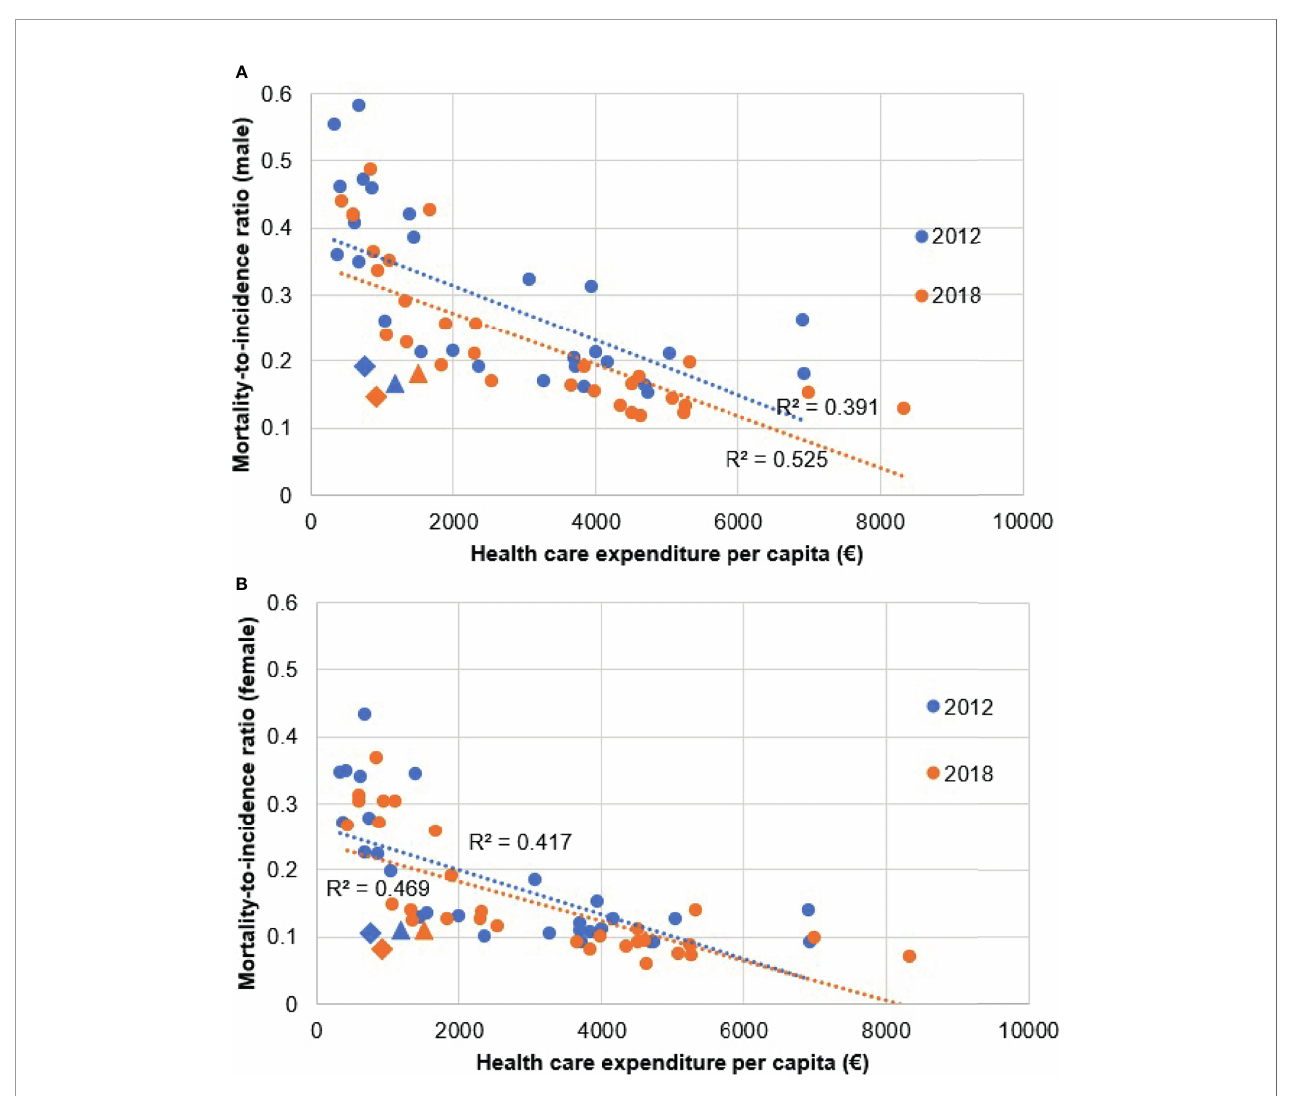
FIGURE 4 | Correlation between melanoma mortality-to-incidence ratios and health expenditure per capita in 2012 and 2018 using the ESP 1976 dataset. (A) male patients, (B) female patients. Diamond shaped plot points indicate Hungary, triangle shaped plot points indicate